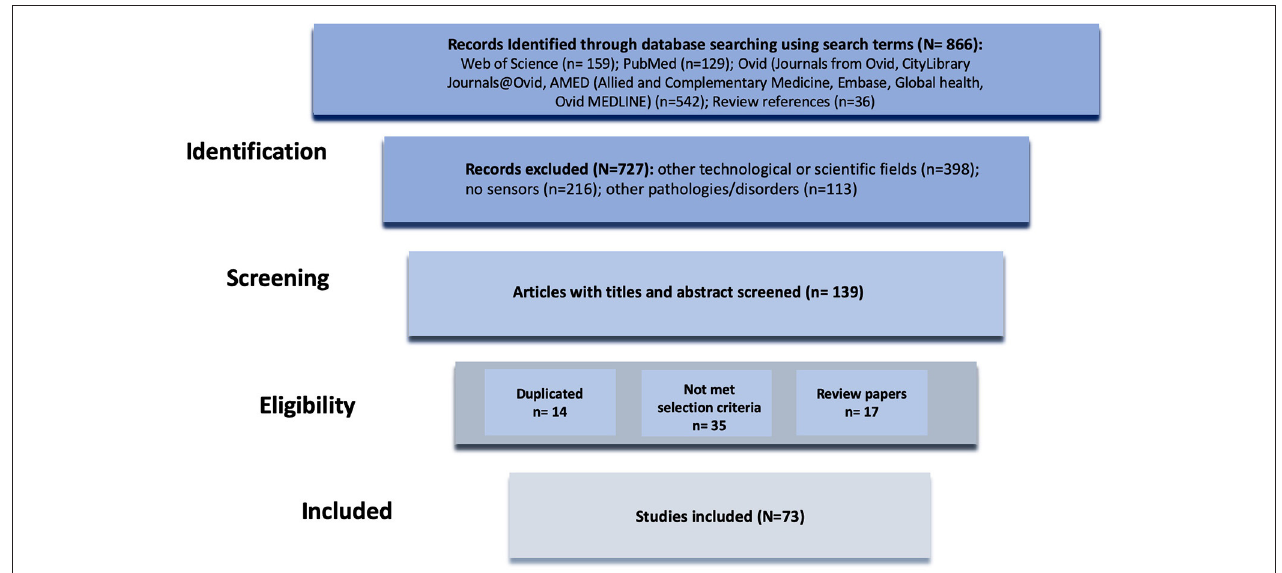
FIGURE 1 | Diagram of the methodology used for the literature review